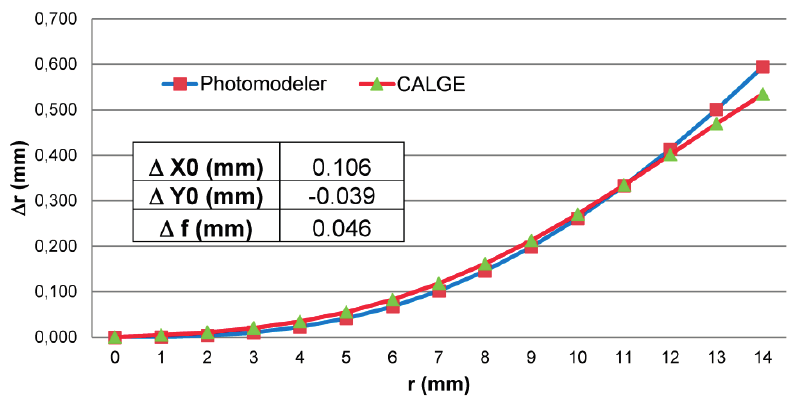
Figure 3. Curve of radial distortions evaluated for the Nikon D100 camera using the CALGE (green triangles) and Photomodeler (red squares) software packages. The difference between the PP coordinates and the focal lengths obtained are shown in the embedded